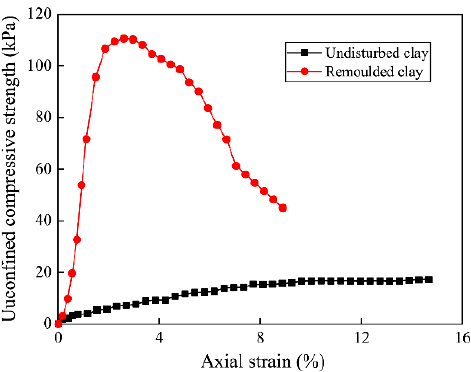
Figure 3. Curves for unconfined compression tests of undisturbed clay and remolded clay.